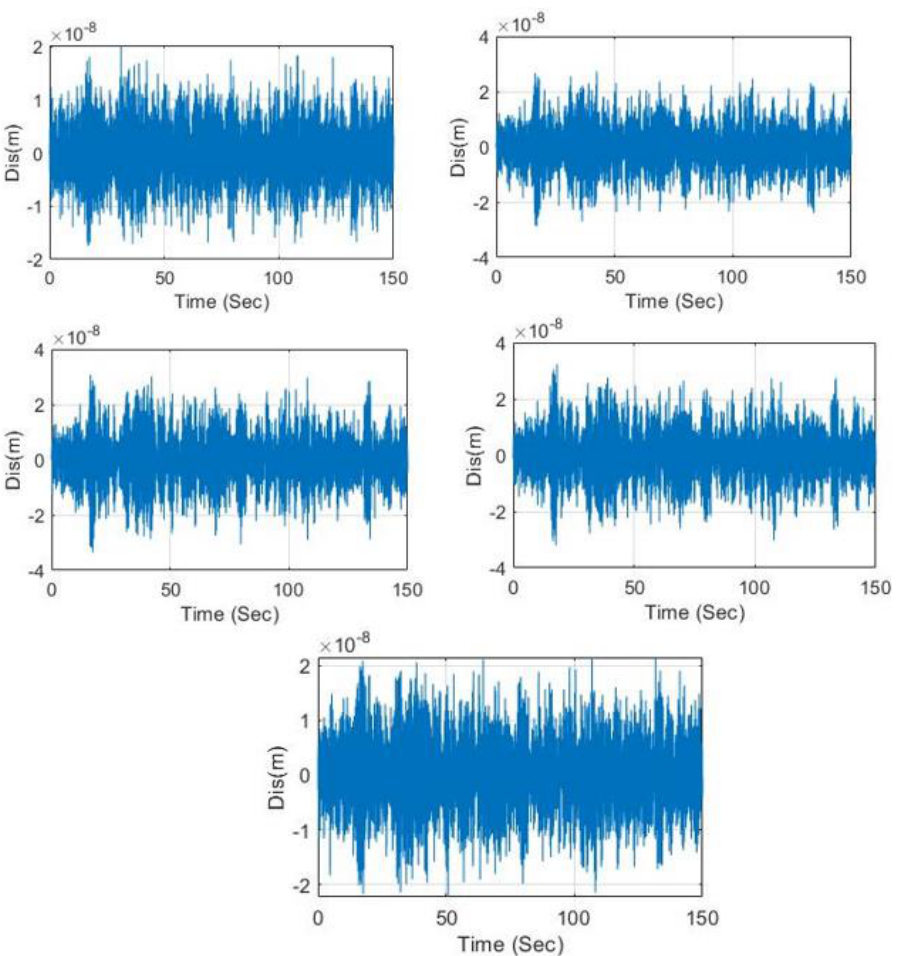
Figure 2. Calculated displacement responses.